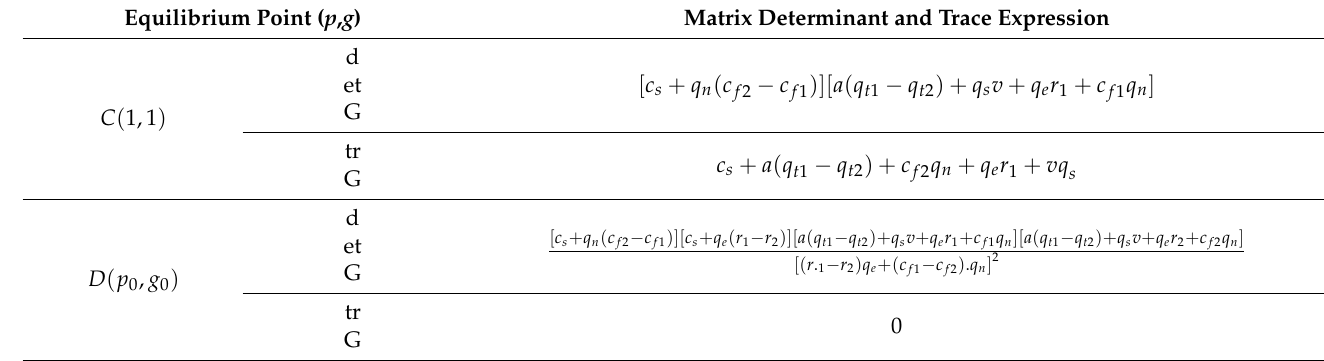
Table 3. Cont. Equilibrium Point ( p , g ) Matrix Determinant and Trace